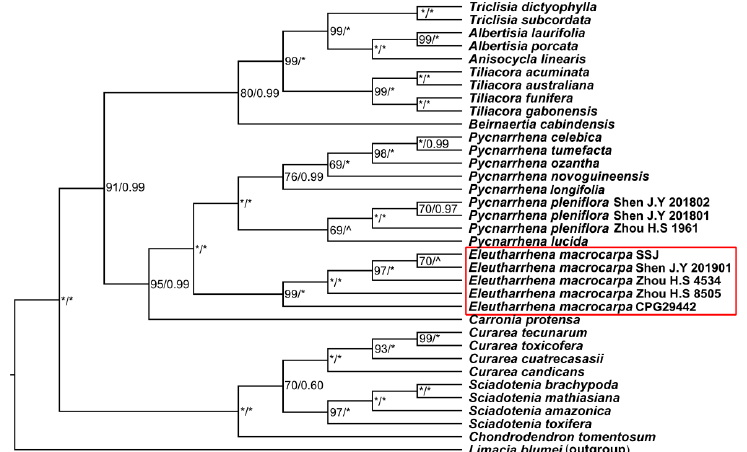
Figure A1 . Heuristic search and majority rule consensus of Tiliacoreae based on 17 morphological characters using Mesquite. Endocarp ancestral character states mapped and visualized using the ball and stick method. Consensus tree supports 1 except when stated.